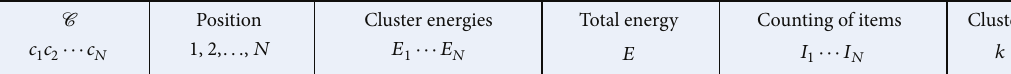
Figure 1: Coding structure of clusters.